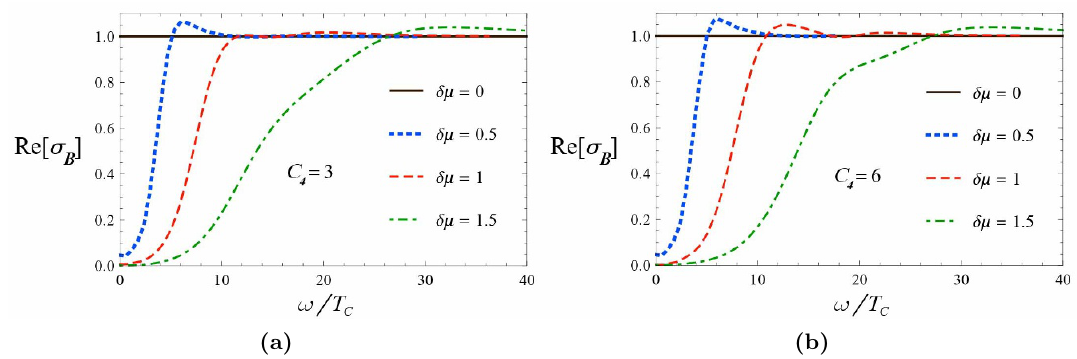
Figure 9. The real part of spin conductivity in terms of !=T c for (cid:14)(cid:22) = 0 ; 0 : 5 ; 1 ; 1 : 5 (solid curve, dotted curve, dashed curve, dot-dashed curve) and function F ( ) = 2 + C 4 4 . We have considered the non-vanishing C 4 = 3 (left) and C 4 = 6 (right) in order to highlight the